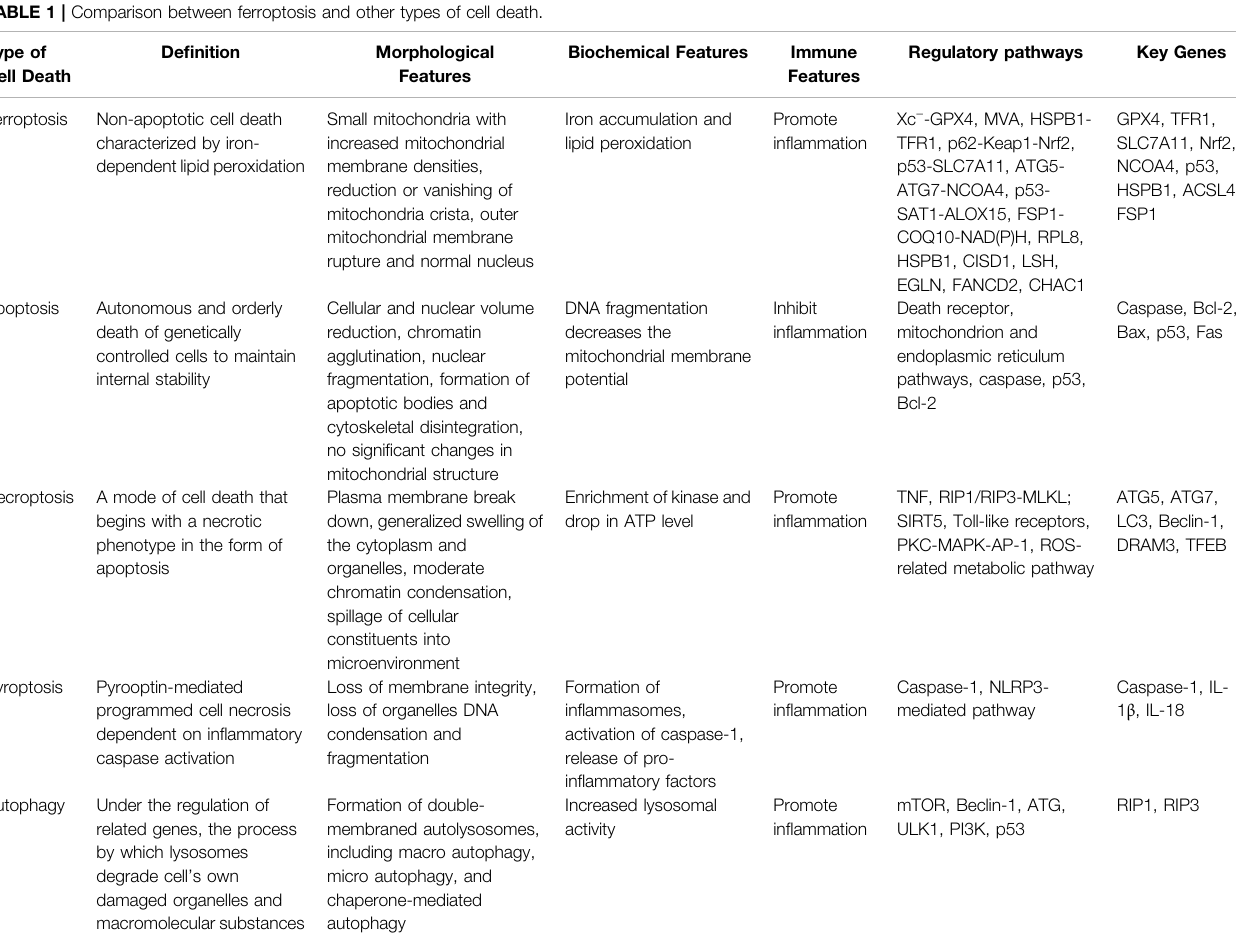
TABLE 1 | Comparison between ferroptosis and other types of cell